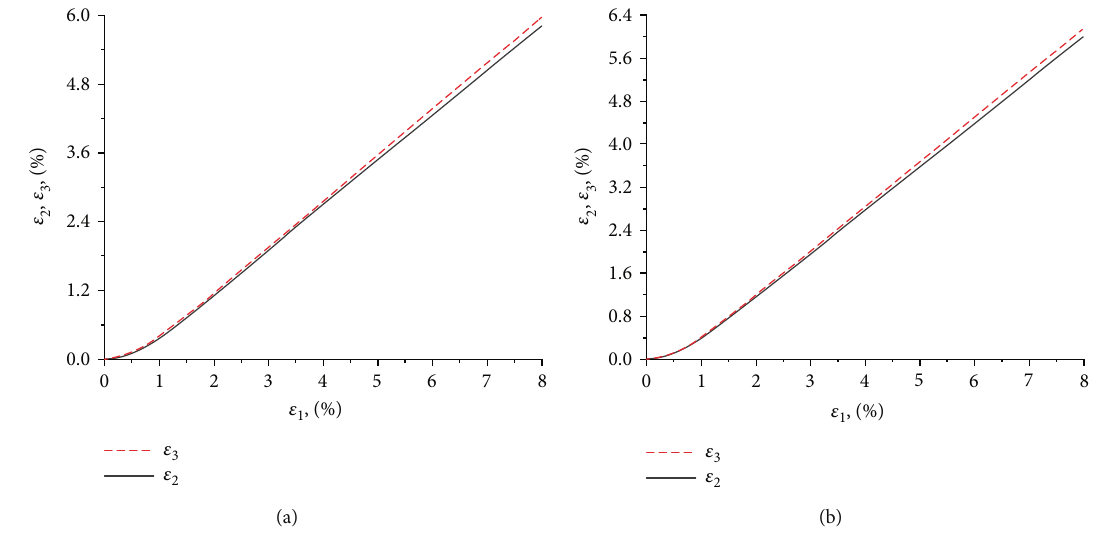
θ =30 ° ; (b) θ =60 ° 3 =300KPa): (a)